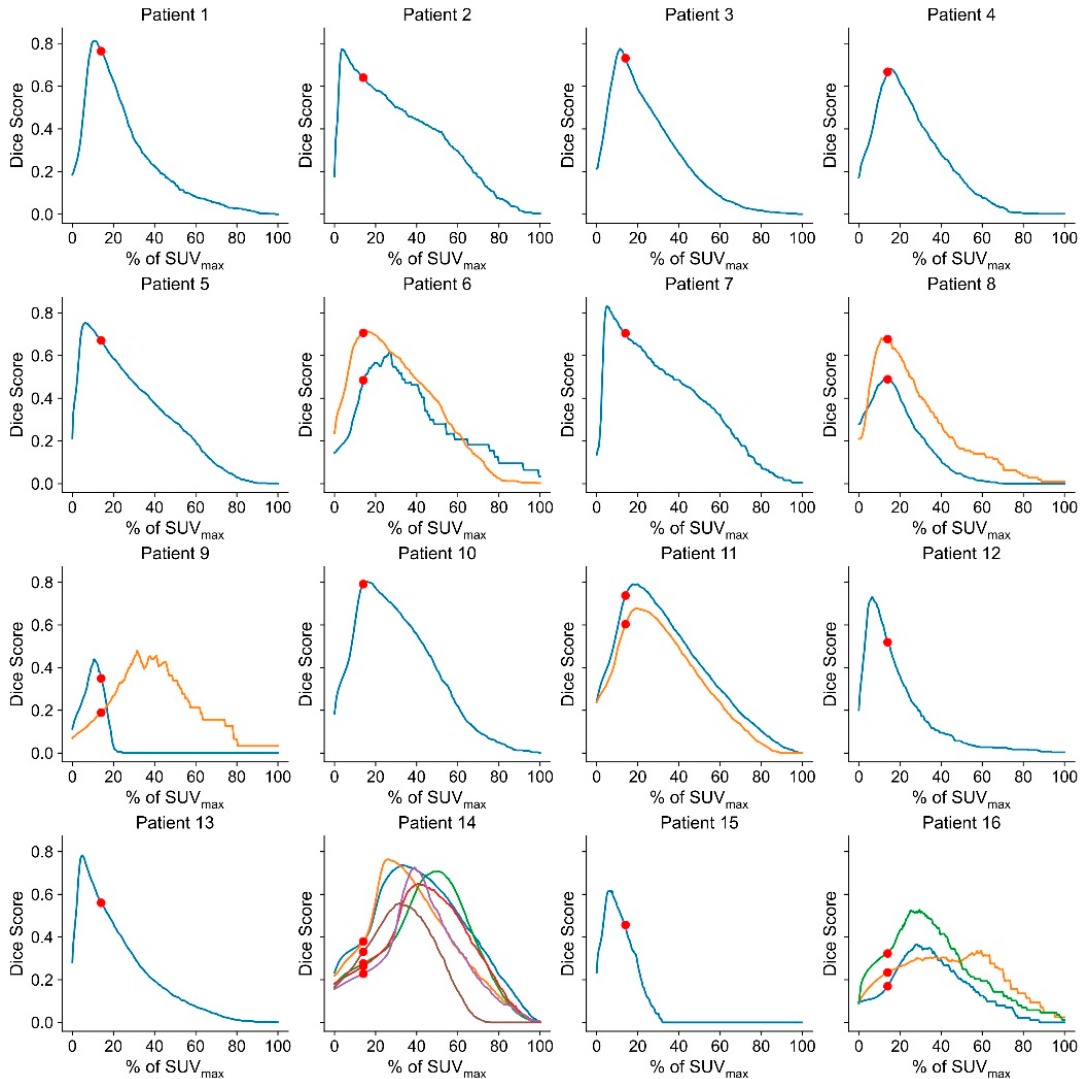
Figure 4 . Dice score plotted against the threshold value % of SUVmax for every patient. The red dots mark the % of SUVmax, which maximized the overall Dice coefficient. For Patients 6, 8, 11, 14, and 16, multiple lesions were present (depicted as different lines), which were treated independently for the calculation of the threshold.